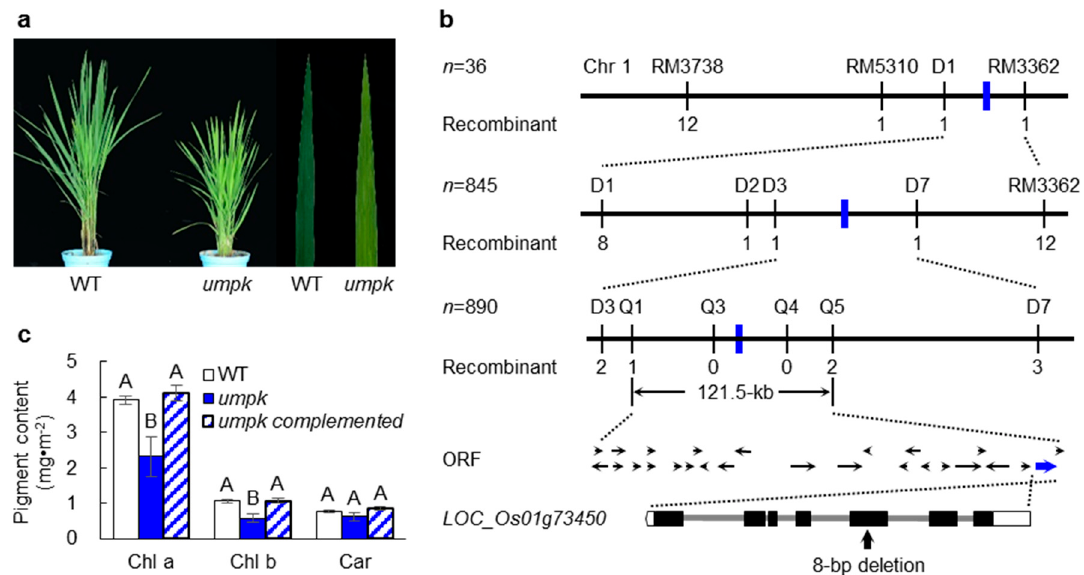
Figure 1. Map-based cloning of UMPK . ( a ) Phenotypes of the two-month-old wild type (WT) and mutant. ( b ) Map-based cloning of UMPK locus. ( c ) Chlorophyll contents of the WT, the mutant, and transgenic lines. Data represent means ± sd ( n = 5). Bars with different letters are significantly different at p < 0.01 based on Duncan’s multiple range tests.